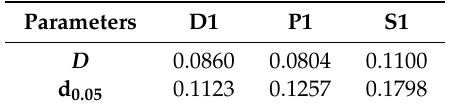
Table 3. Fitting results of marginal distribution